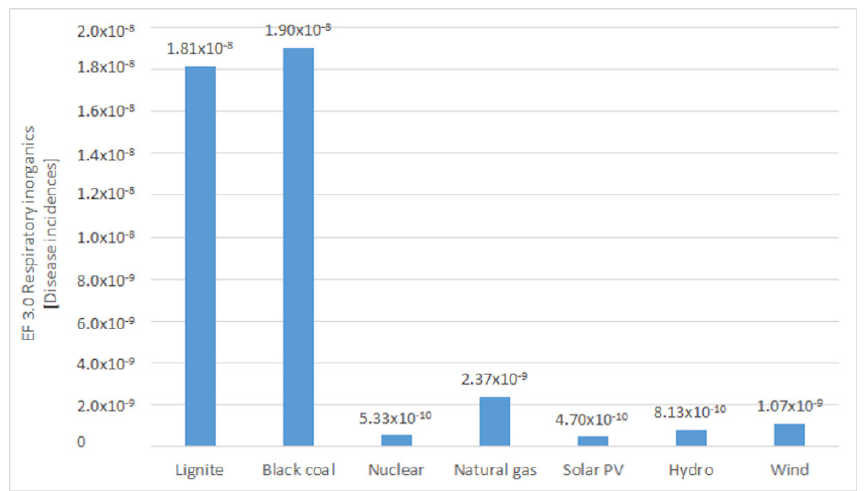
Figure 8. Environmental impacts of selected energy sources on the water scarcity category. The results relate to 1 kWh of electricity supplied to the grid. The results are expressed in m 3 world equivalent.